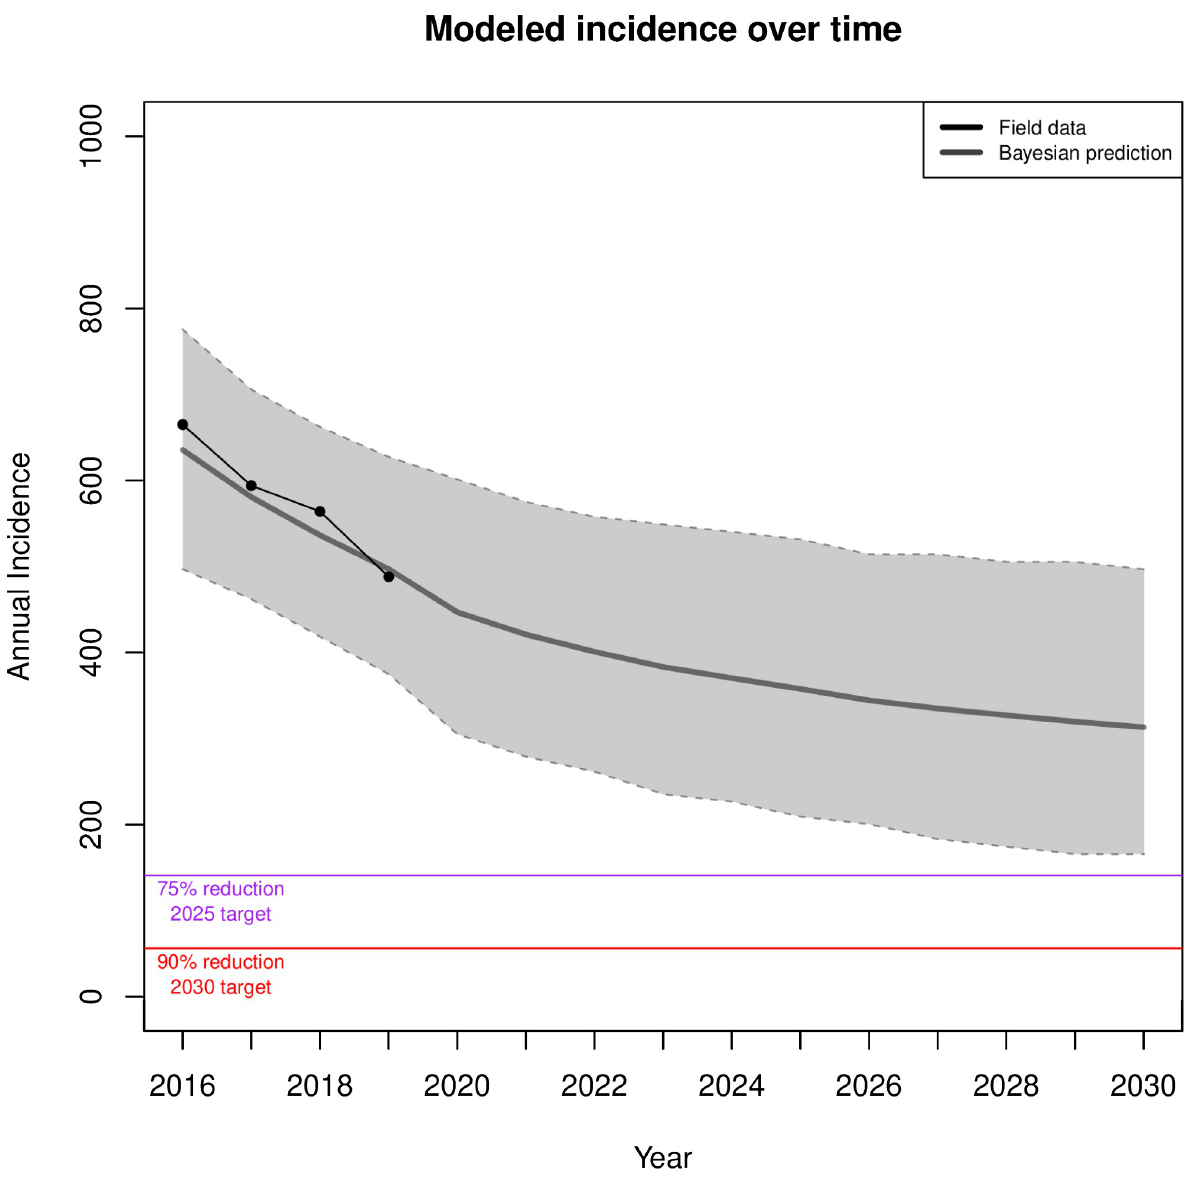
Fig 7. Projected number of incidence cases over time based on Bayesian posterior predictive distribution: Solid line shows the mean projection; colored surface, the 80% Prediction Interval. The black line shows observed levels based on the most recent CDPH surveillance data.